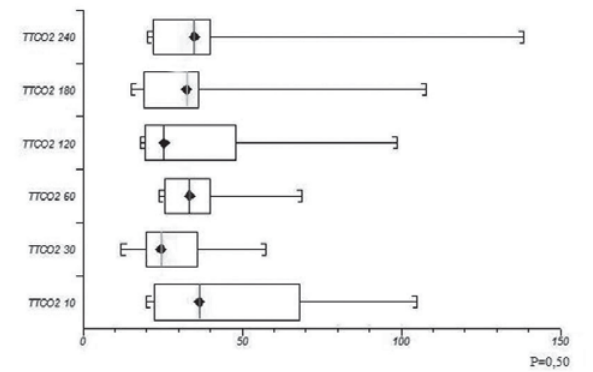
) em Fig. 4 – Dosagens de hemoglobina livre (HBL) previamente e nos 2 diferentes tempos da circulação extracorpórea